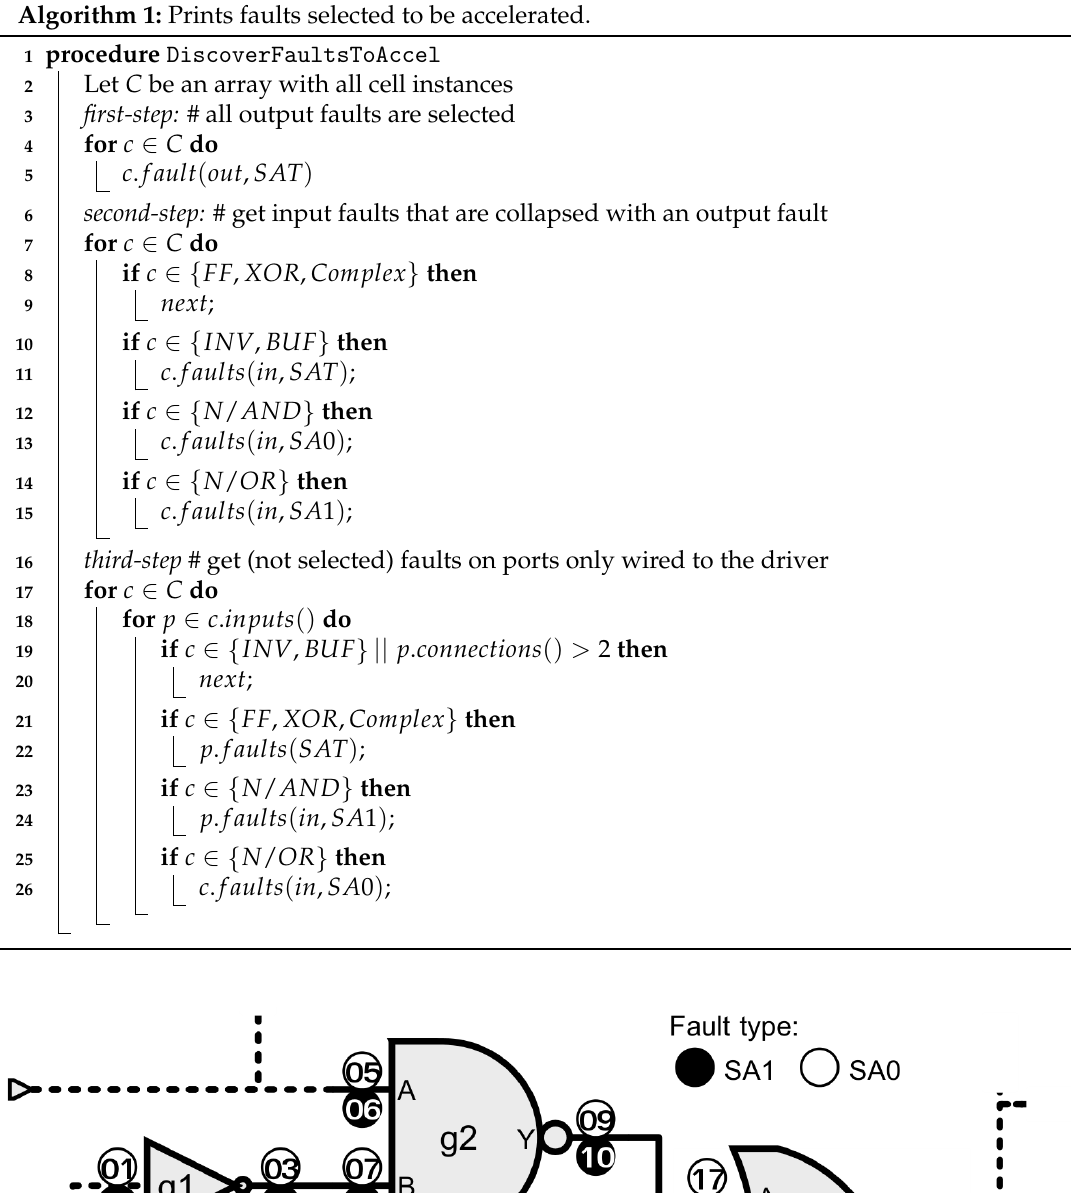
Algorithm 1: Prints faults selected to be accelerated.